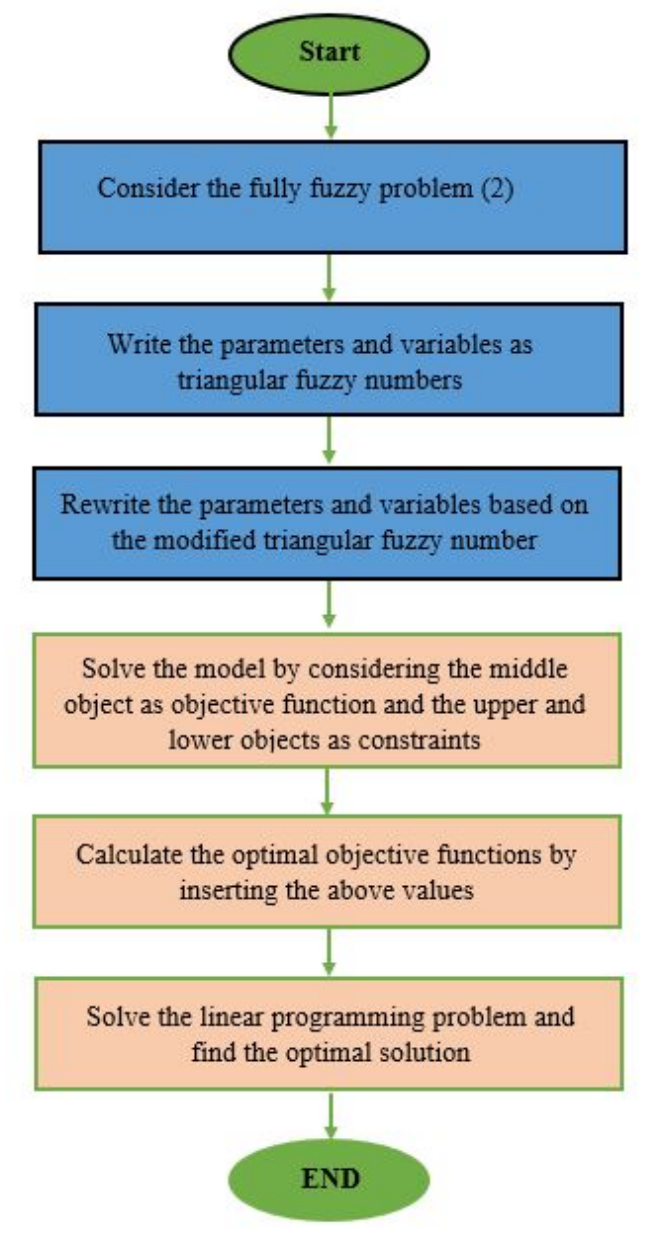
Figure 3. The flow chart of the proposed